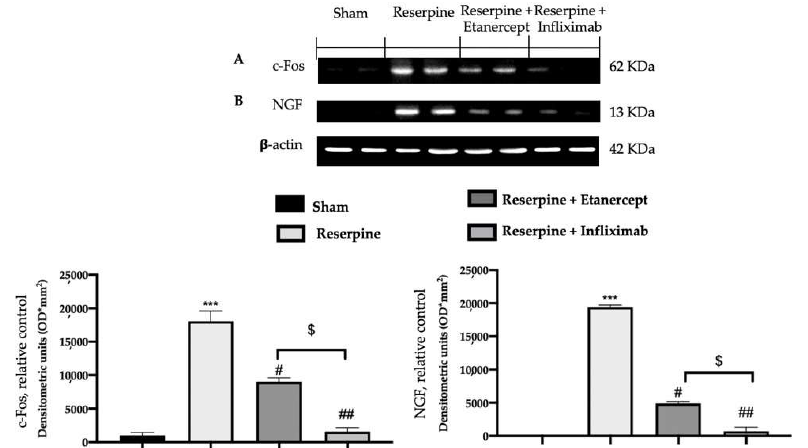
Figure 3. Efficacy of etanercept and infliximab administration on c-FOS and NGR overexpression reserpine induced. Western Blot analysis of: ( A ) c-FOS and ( B ) NGF expressions. For these analyses n = 5 animals for each group were employed. Shown is a representative blot of lysates from five animals per group, together with a densitometric analysis normalized to housekeeping proteins. Results were analysed by one-way ANOVA followed by a Bonferroni post-hoc test for multiple comparisons. A p -value <0.05 was considered significant. # p < 0.05 vs. vehicle, ## p < 0.01 vs. vehicle, *** p < 0.001 vs. sham, $ p < 0.05 infliximab vs. etanercept.